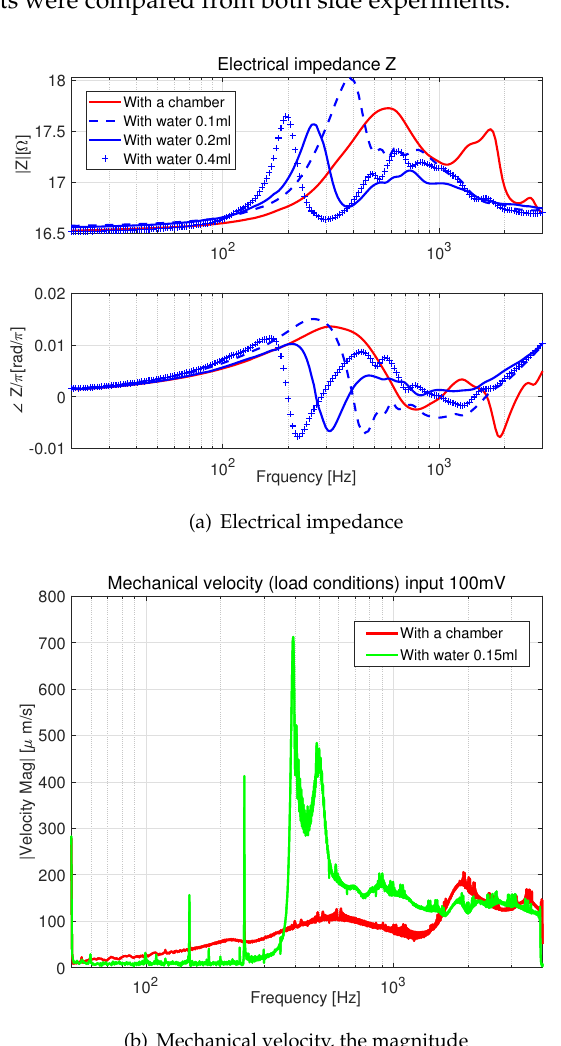
Figure 4. The electrical impedance and mechanical velocity measurement results from the electromagnetic mixer introduced in Figure 2. Two loading conditions are examined: an empty chamber or filled with water. For the electrical impedance measurement, three different water volumes were tested to validate the numeric model suggested in Equations (22) and